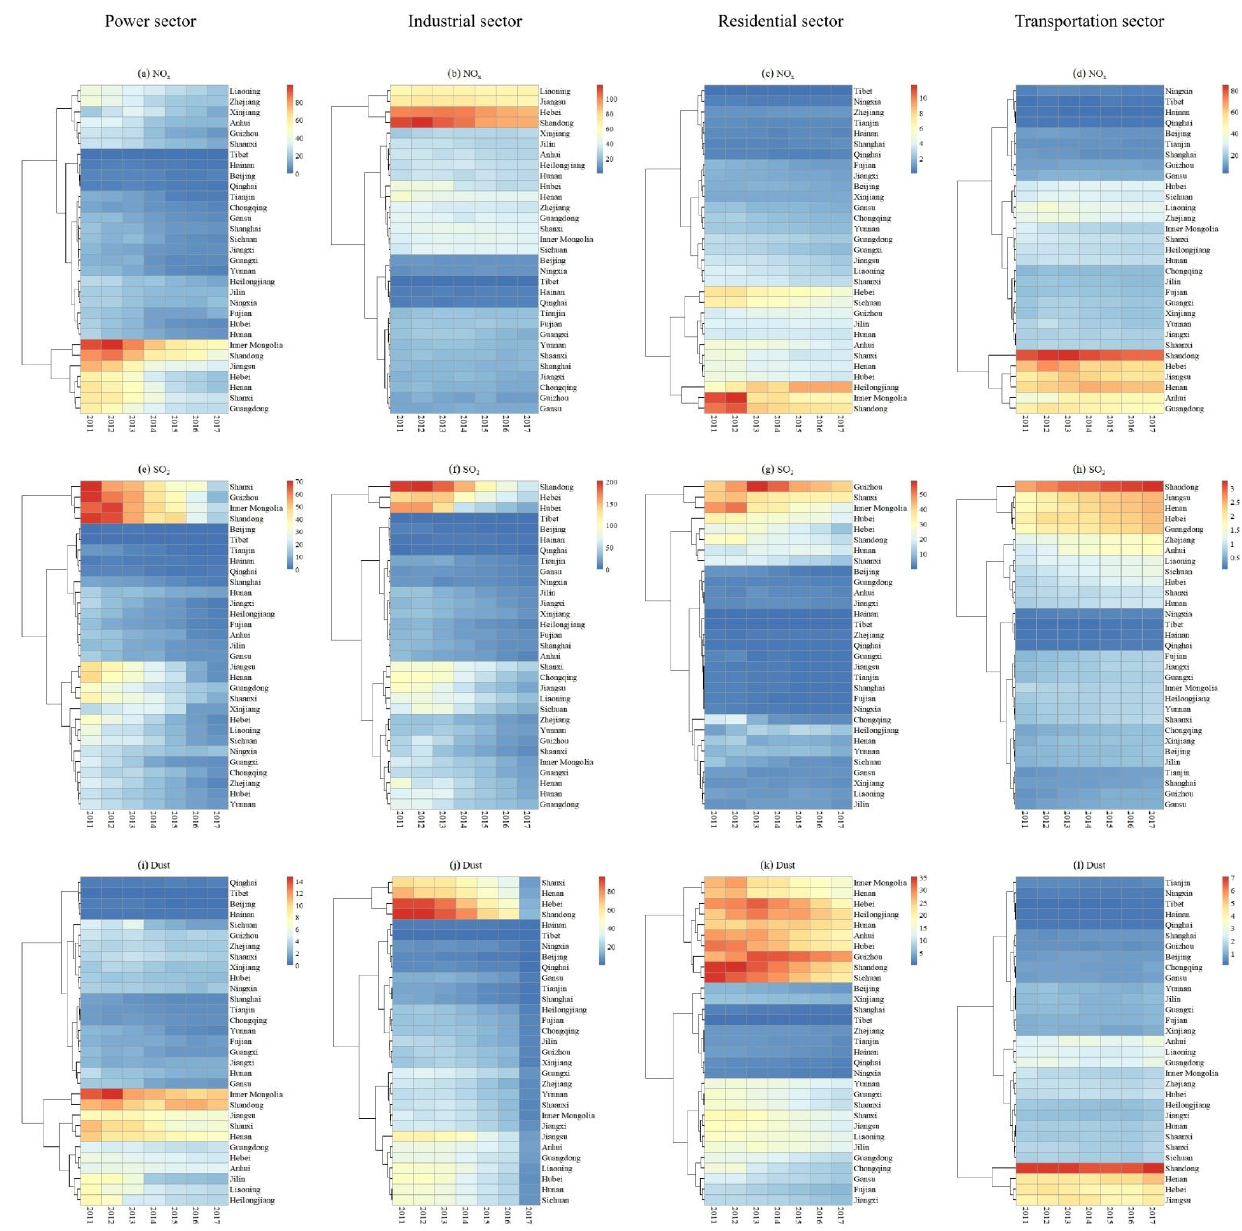
Figure 5. Distribution of pollutant (NO x , SO 2 , and dust) emissions from the ( a , e , i ) power sector, ( b , f , j ) industrial sector, ( c , g , k ) residential sector and ( d , h , l ) transportation sector in China (2011 − 2017).